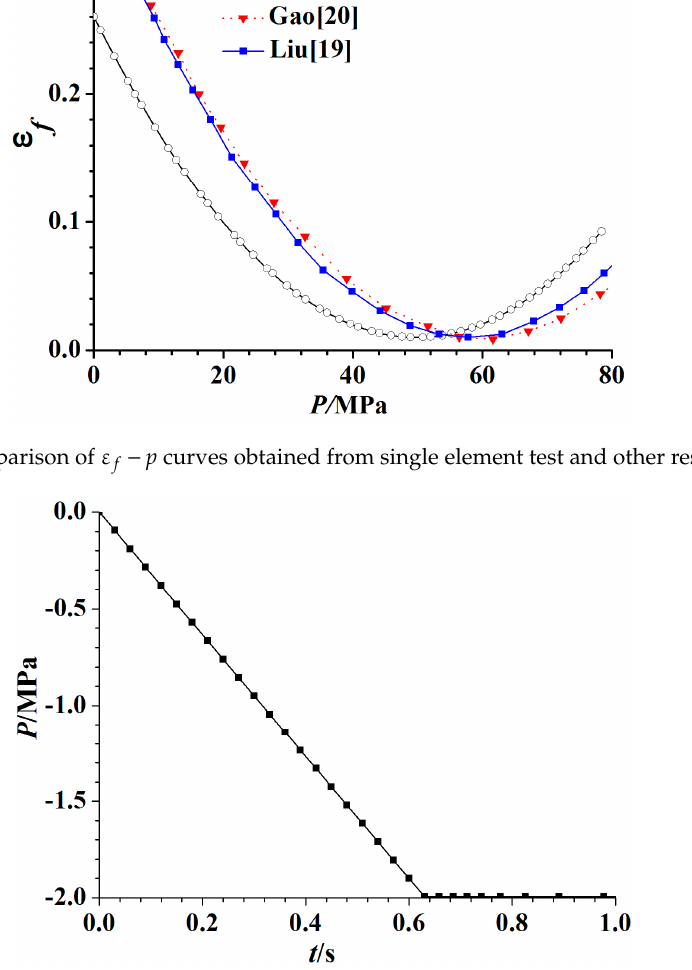
Figure 5. Relationship obtained from single element test.